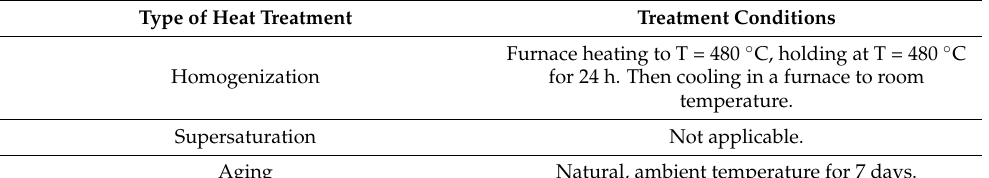
Table 2. Heat treatment temperature parameters for cast AB-71100 aluminum alloy [32–37].